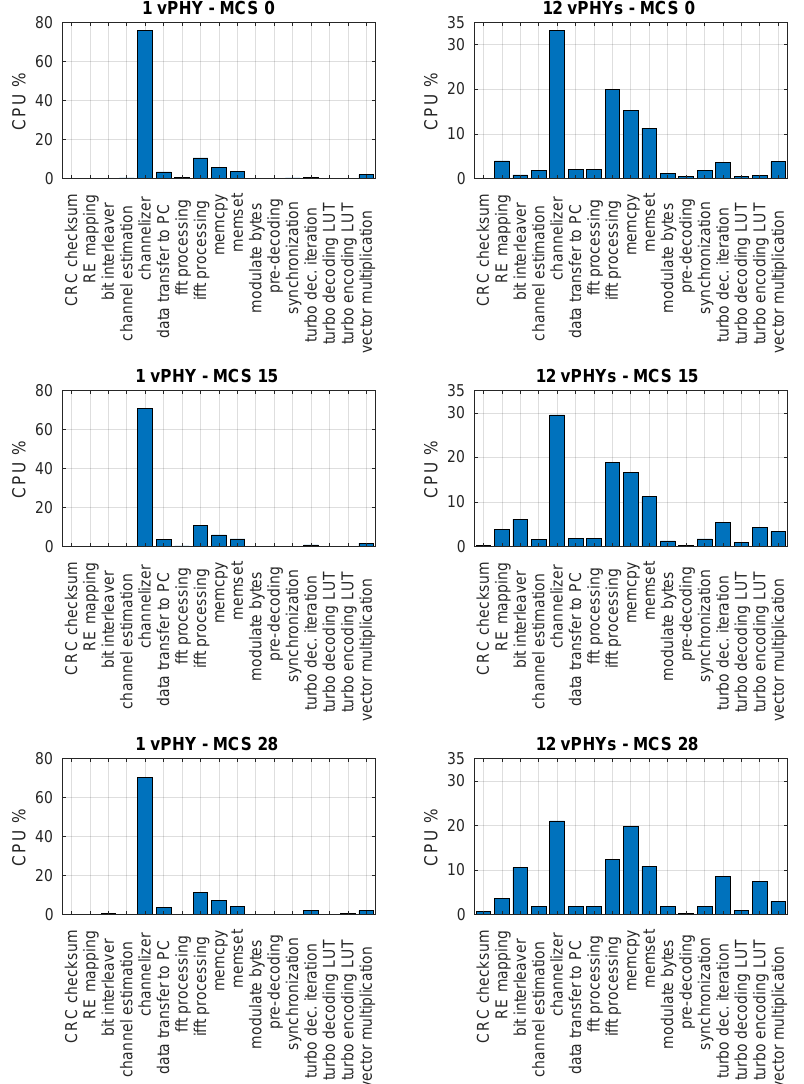
Figure 23. CPU profiling of individual components of the architecture prototype for 1 and 12